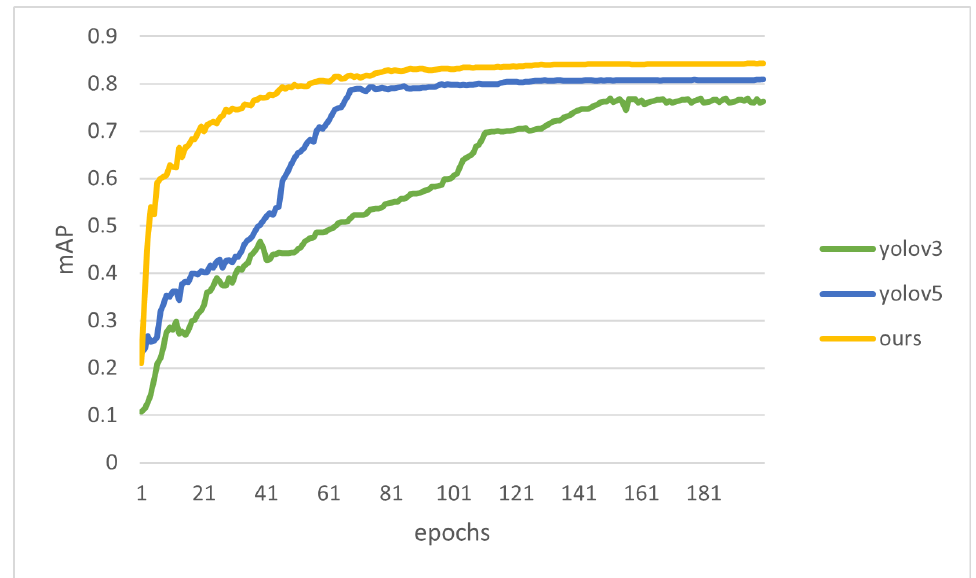
Figure 9. Relationship between mAP curve and period of different models.